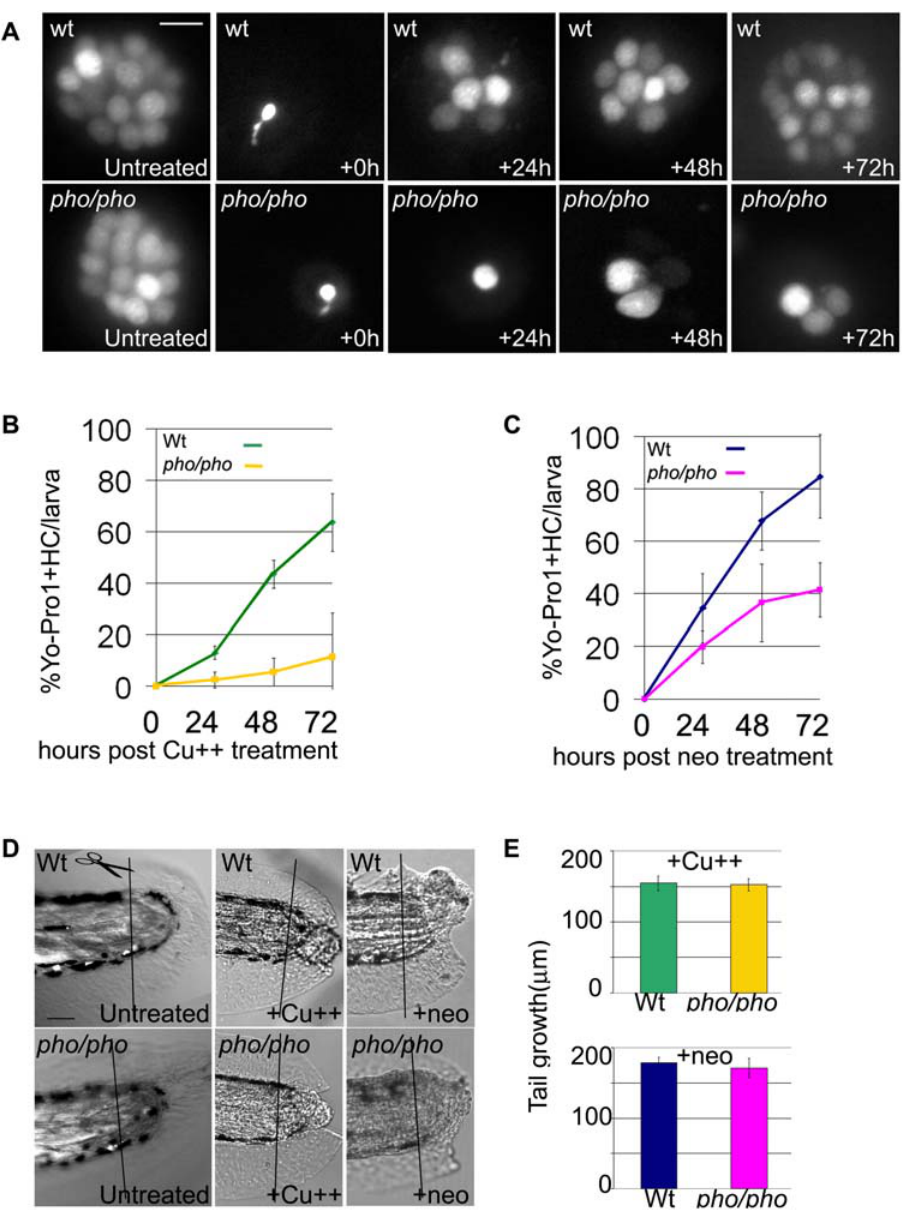
Figure 3. Lateral line hair cell regeneration is severely reduced in phoenix mutants but regeneration in other tissues is not affected. (A) Neuromasts of the lateral line are stained with YoPro 1, which exclusively stains hair cells. We treated wild-type (top panels) and pho/pho larvae (bottom panels) at 5dpf with copper (10mM). We monitored regeneration of hair cells over the following three days, at + 24, + 48, and + 72h. As a reference, 5dpf wild-type and mutant neuromasts are shown just prior to treatment and just after the treatment (untreated and + 0h, respectively, in the first and second columns from the left). (B) and (C) The number of hair cells was counted in untreated wild-type and mutant larvae at 5dpf (n=39/ 53), 6dpf (n=37/37), 7dpf (n=23/22), and 8 dpf (n=20/15). In each larva, we counted ten head neuromasts and all the tail neuromasts. We counted hair cells in healthy surviving larvae after 10 mM copper (B) or 200 mM neomycin (C) treatments. In (B), we counted wild-type (green line) and mutant (yellow line) larvae at + 24h, (n=40/36), + 48h (n=23/32), and + 72h (n=25/19), respectively, after copper treatment. In (C), we counted wild-type (blue line) and mutant (pink line) larvae at + 24h, (n=40/36), + 48h (n=23/32), and + 72h (n=25/19), respectively, after neomycin treatment. The numbers are presented as a percentage of regenerated hair cells in treated larvae, 100% being the respective number of hair cells at equivalent untreated wild- type and mutant stages. (D) We monitored the regeneration of tails in wild-type (top panels) and mutant (bottom panels) larvae. In untreated larvae (left panels), we amputated the tail at 3dpf and monitored the regeneration until 9dpf in wild-type (n=8) and mutant (n=20). We monitored the partial regeneration of tails amputated at 5dpf after copper (middle panels) and neomycin treatment (right panels). (E) Quantification of the tail regeneration after amputation at 5dpf after the copper treatment (upper graph), as measured in 8dpf wild-type (green, n=11) and pho/pho (yellow, n=10) larvae and after neomycin treatment (lower graph), as measured in 9dpf wild-type (dark blue, n=6) and mutant (pink, n=7) larvae. – 10 microns in (A) and 50 microns in (D).